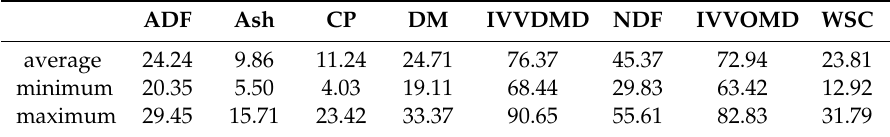
Table 5. Canopy spectra from 1610 plants was analyzed using the previously tested predictive models, the average, minimum and maximum predicted value for each NV parameter in all 1610 samples are shown